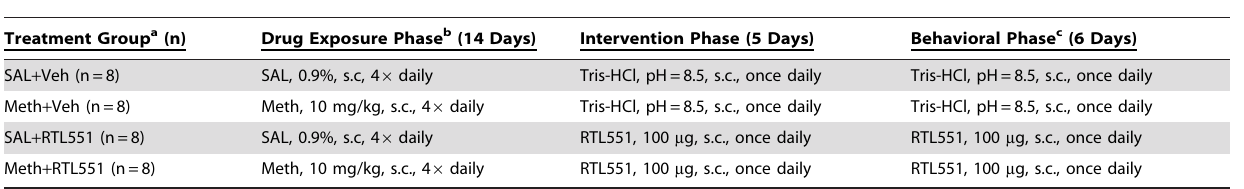
Treatment Group a